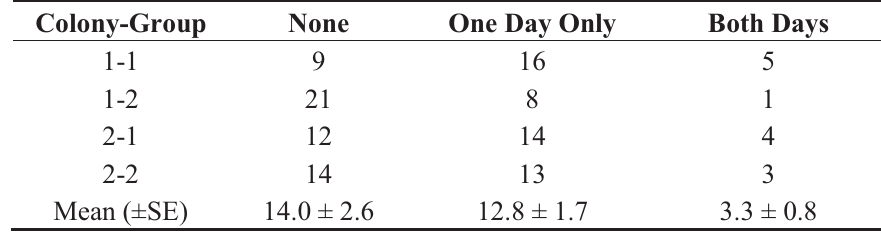
Table 3. Number of termites in three categories of time spent tunneling (none, one day only, both days) from both trials conducted on consecutive days with the same group of 30 workers with two groups from each colony.